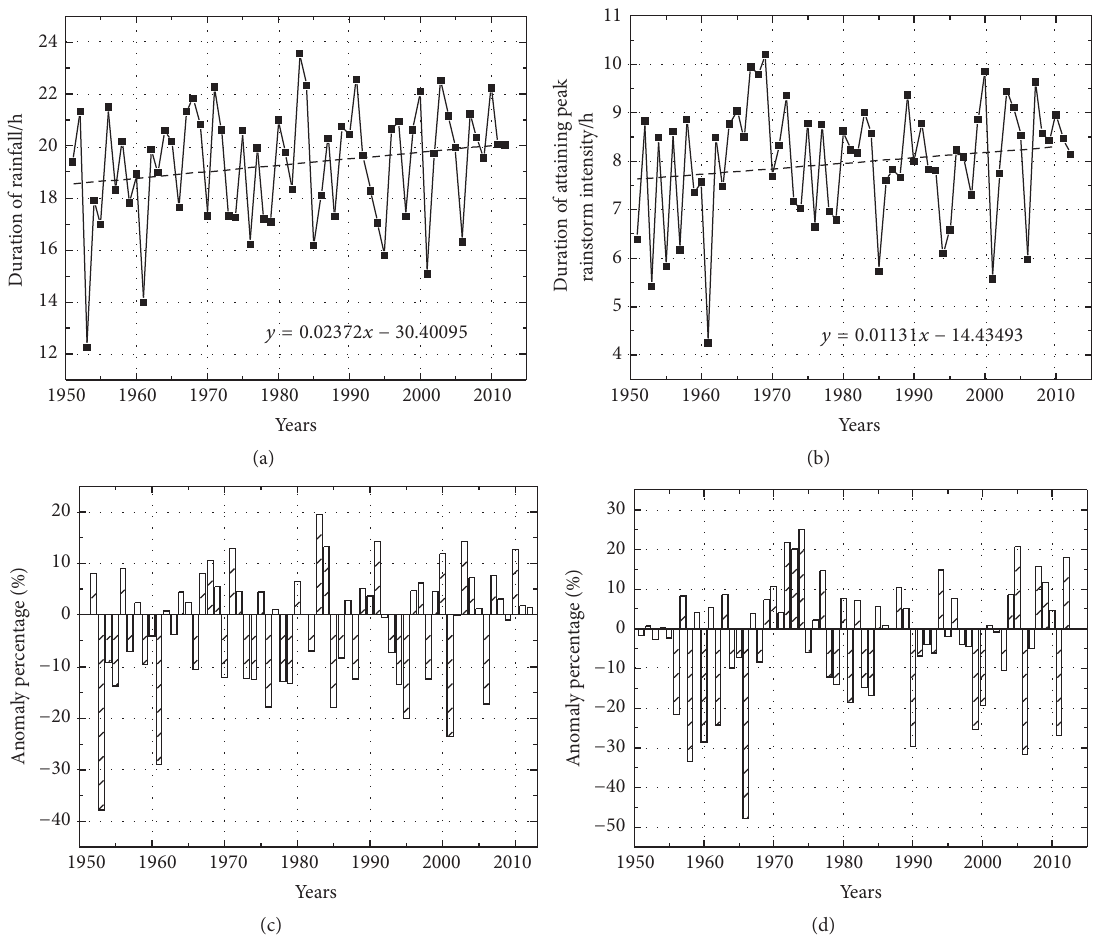
Figure 6: Variation of average duration of isolated rainstorms and their peak